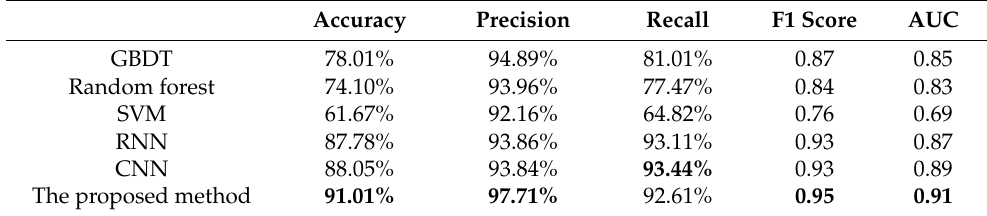
Table 6. Comparison of the verification results of the UAV Flight data